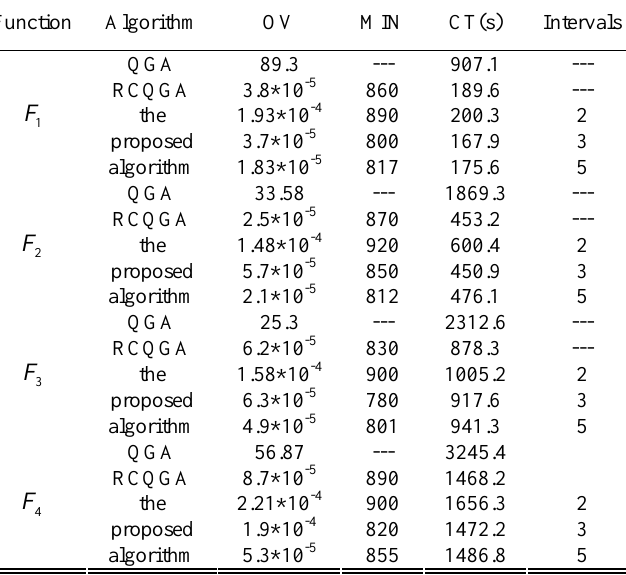
Table 2. Benchmark functions testing results